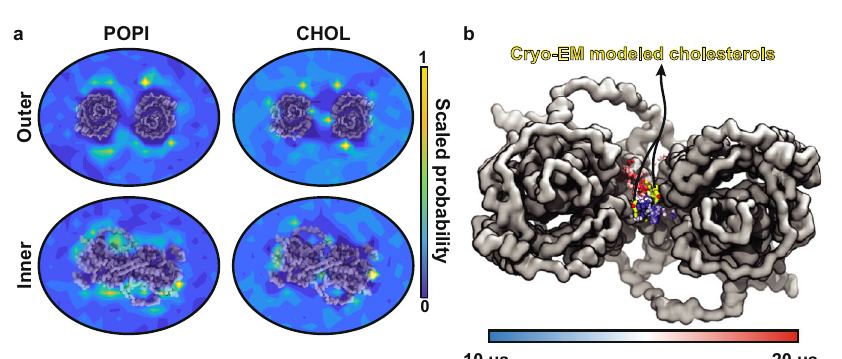
Fig. 7 | Accumulation of POPI and CHOL around prestin. a Heatmaps repre- senting the distribution of POPI and CHOL over the last 5 μ s of the quad-prestin trajectory in the contracted conformation. Both POPI and CHOL cluster closely to the core and gate domains of prestin. The region in between the two protomers contains two distinct CHOL binding sites but remains free of POPI during the